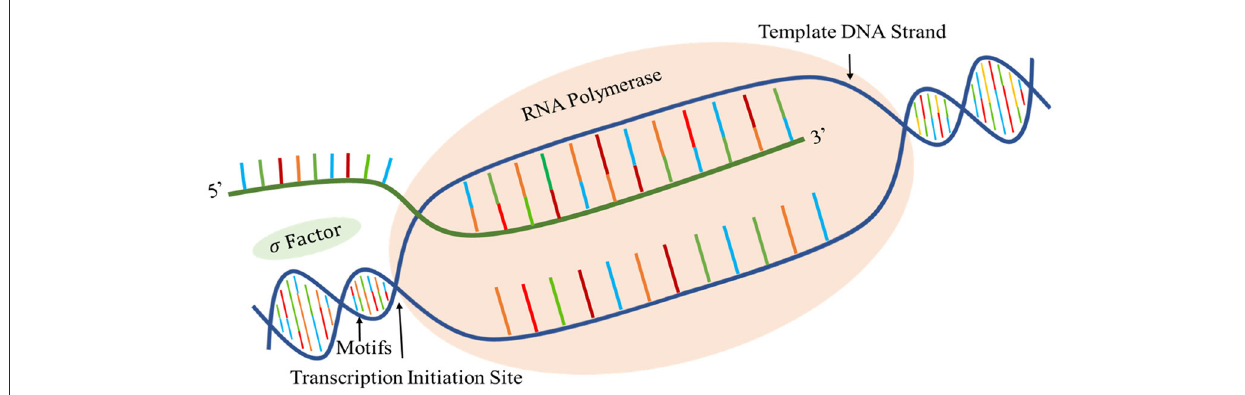
FIGURE1 Schematic diagram of the prokaryotic promotor structure and its biological